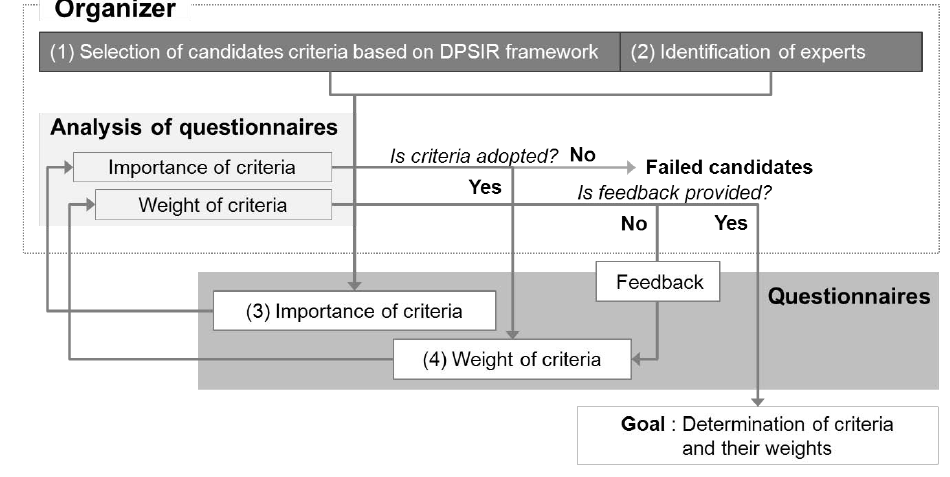
Fig. 3. Delphi procedure of this